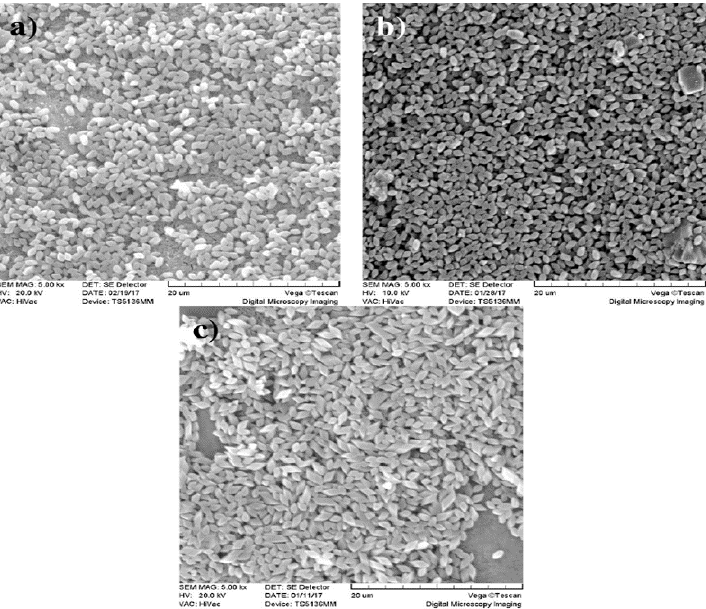
Figure 4. SEM images of the surface of seeded support with a) 0.1 wt% b) 0.2wt% c) 0.3 wt% concentration of seeds solution.